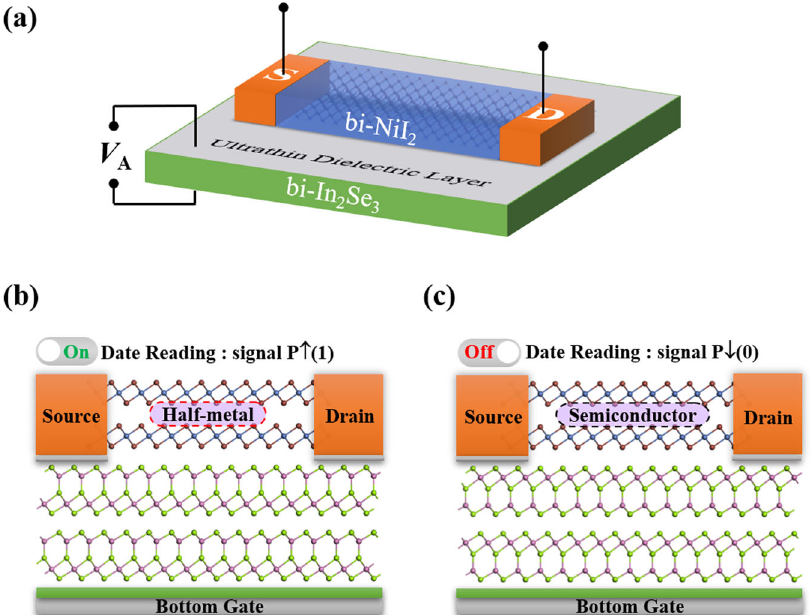
Fig. 5 Device prototype and schematic diagram. a Prototypes of the ferroelectric memory device and spin- fi eld effect transistor based on the bi-NiI 2 /bi-In 2 Se 3 heterostructure. b , c Operation principle of ferroelectric memory device whose data writing depends on FE bi-In 2 Se 3 and data reading is based on the different electric